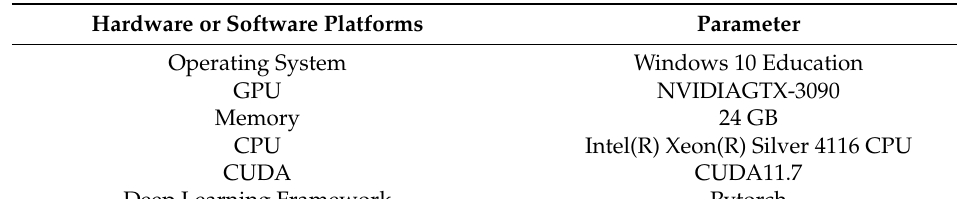
Table 2. Hardware or software platform for experimentation.